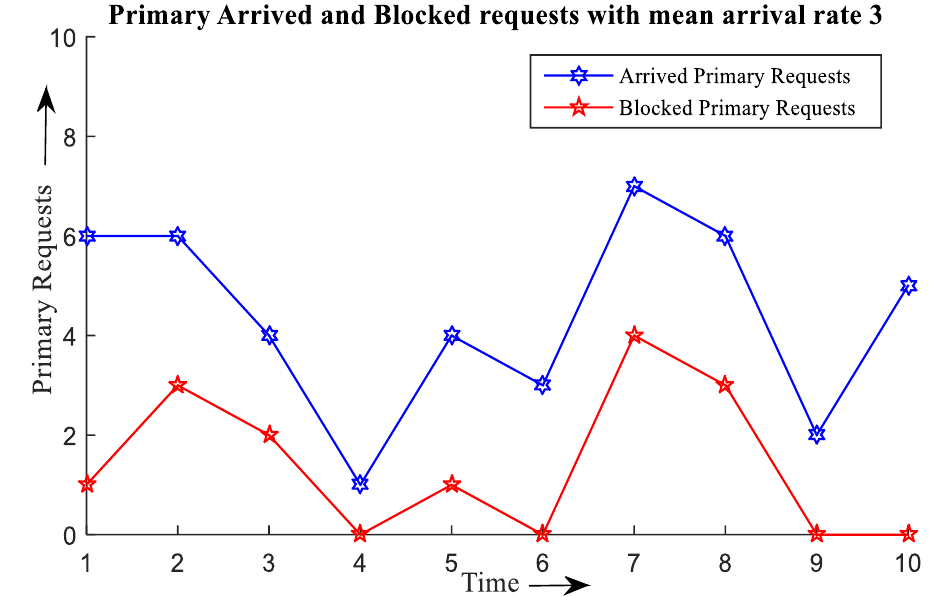
Figure 5. Primary arrived and blocked requests ( 𝜆 = 3